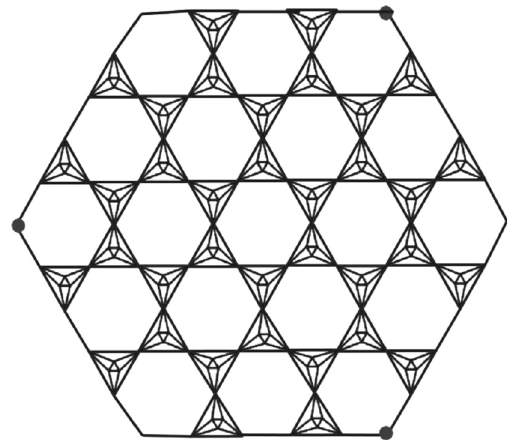
Figure 3: Hex planar octahedron